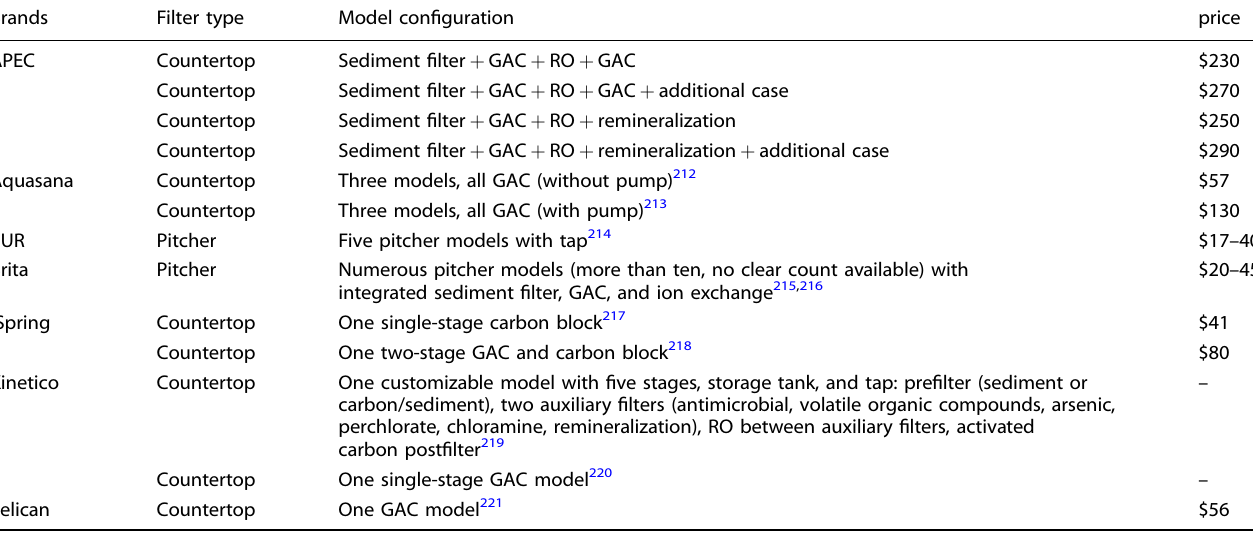
Table 13. Product summary of fi lter media in countertop and pitcher systems.